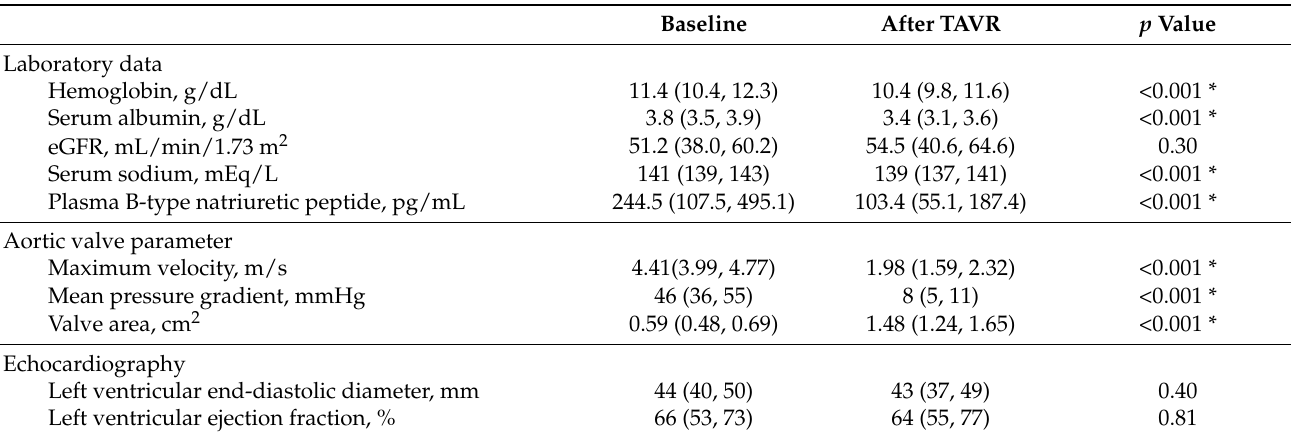
Figure 3. Baseline RST tertiled with baseline plasma B-type natriuretic peptide ( A ), left ventricular ejection fraction ( B ), and cardiac index ( C ). * p < 0.05 using the Kruskal–Wallis test. Table 2. Peri-procedural clinical parameters.